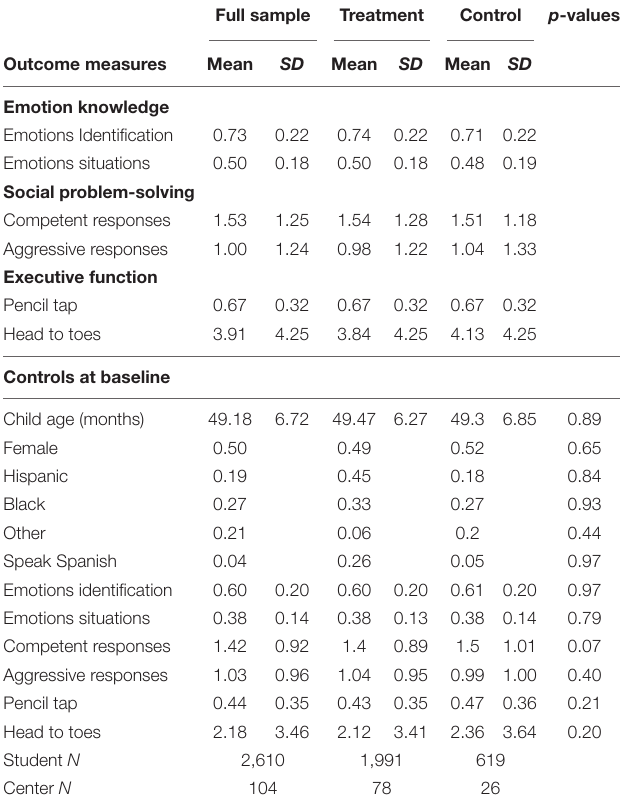
TABLE 1 | Summary